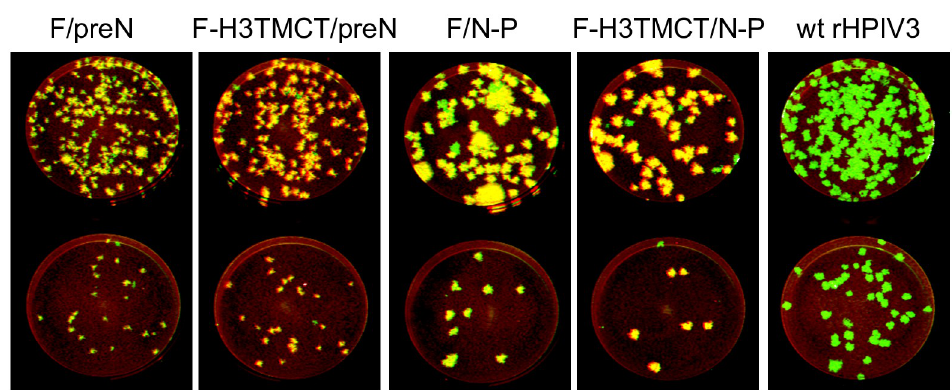
Fig 6. Stability of expression of RSV F protein by rHPIV3-RSV-F vectors after replication in the hamster respiratory tract. Nasal turbinate and lung homogenates prepared as part of the experiment described for Fig 5 were assayed for expression of RSV F protein by a double-staining immunofluorescence plaque assay as described for Fig 2. Representative stained plaques for two dilutions of a lung sample are shown for each group. Quantification is shown